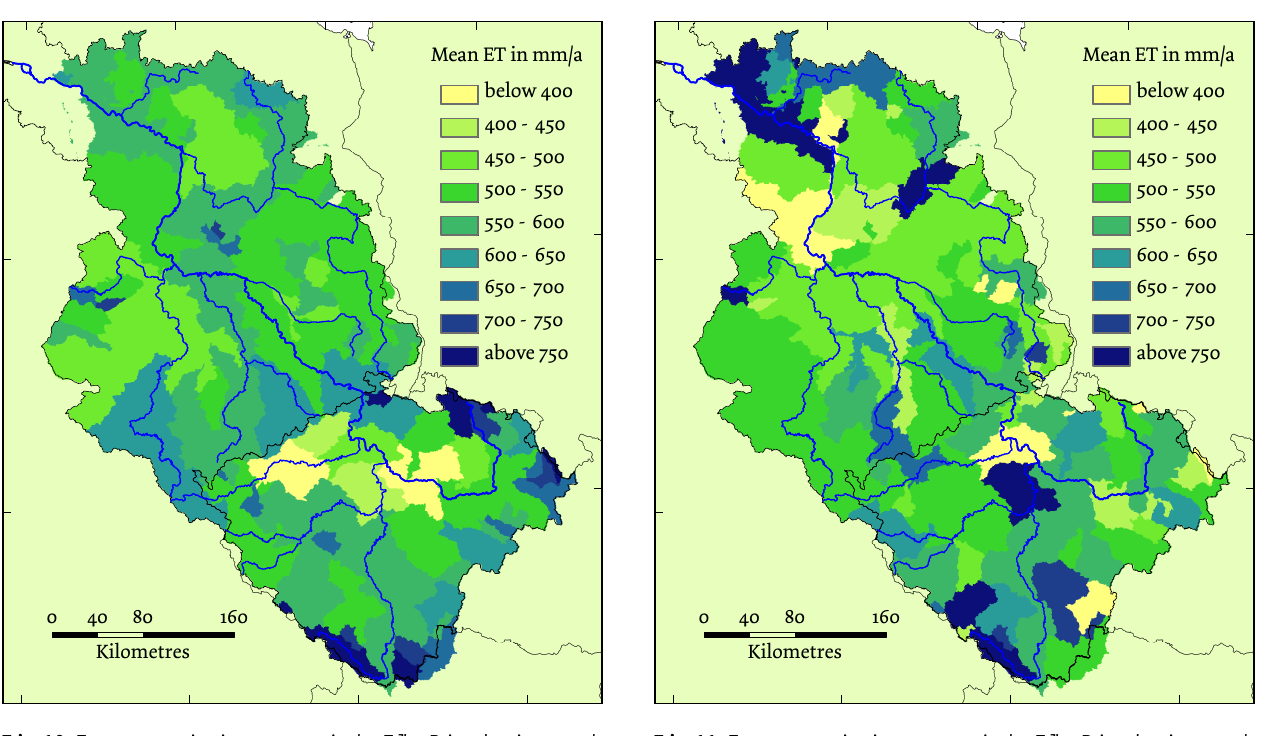
Fig. 10. Evapotranspiration patterns in the Elbe River basin accord- ing to remote sensing. Average values for 133 sub-basins for the years 2001–2003.